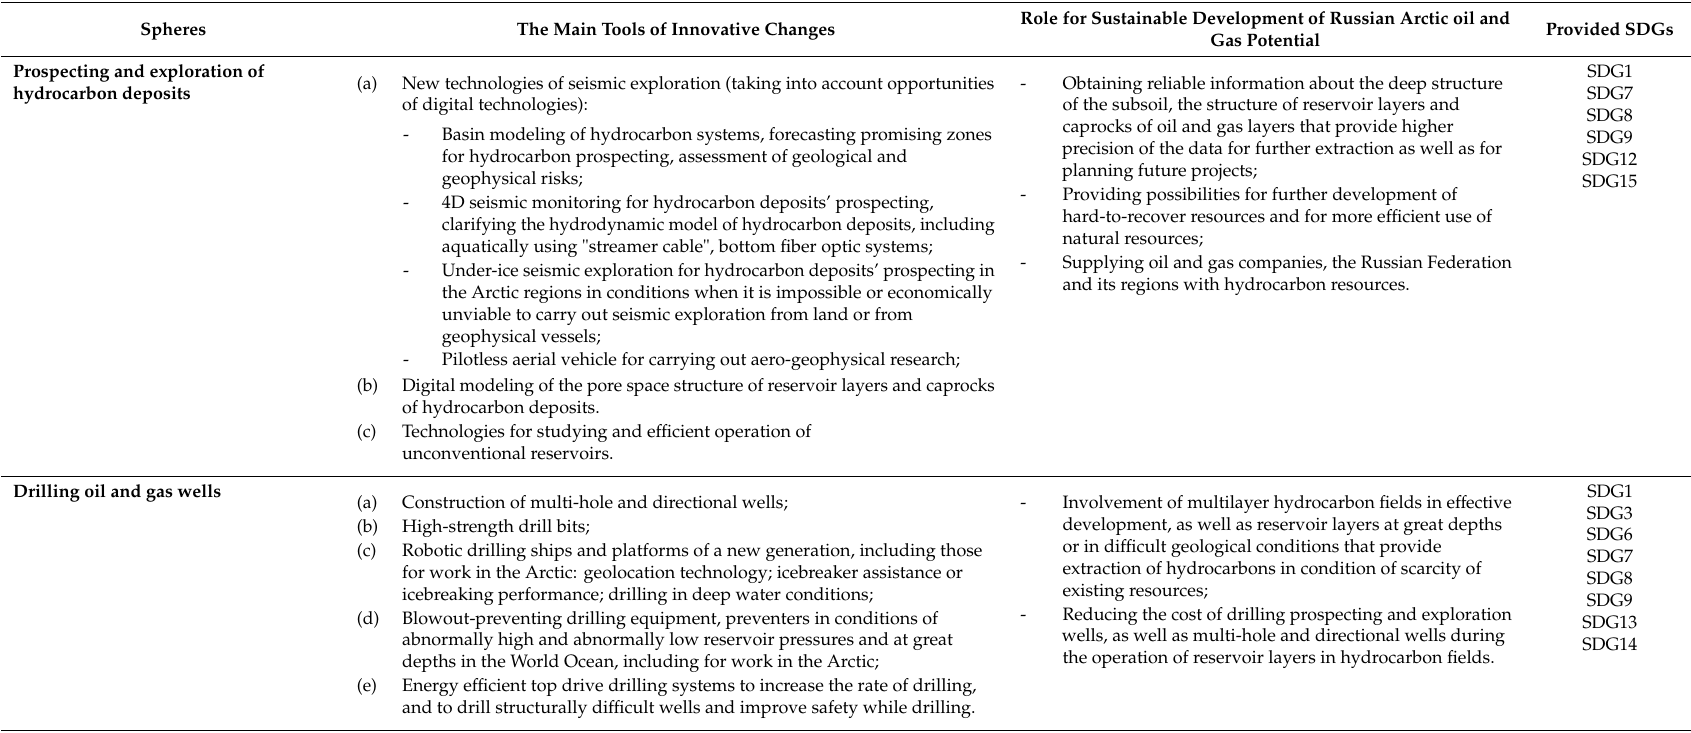
Table 2. Role of innovations in sustainable development of oil and gas potential of the Russian Arctic and its shelf zone.